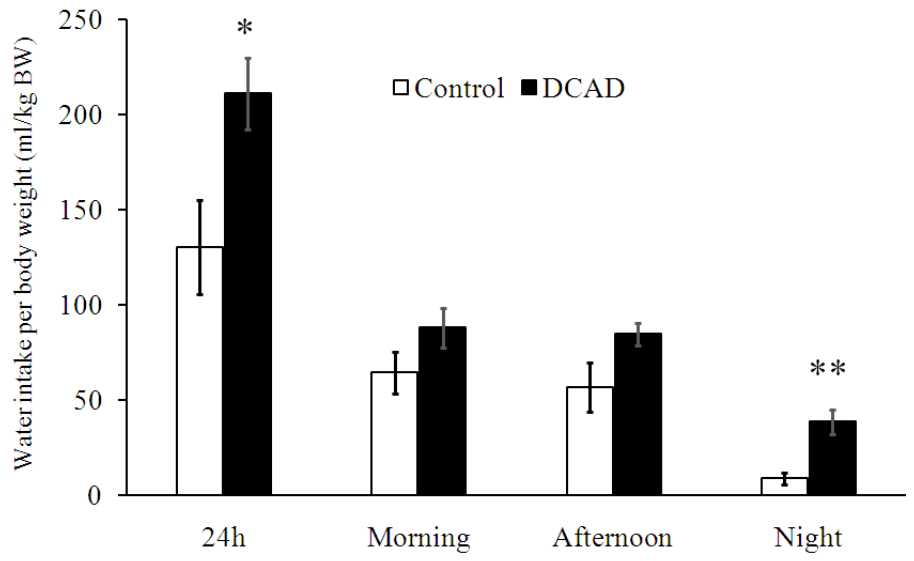
Figure 2. Effects of dietary cation and anion difference (DCAD) on the average 24 h water intake (WI), morning WI from 0700 to 1300 h, afternoon WI from 1300 to 1900 h; night-time WI from 1900 to 0700 h. The DCAD levels from DCAD-23 and DCAD-39 groups were 22.8 and 39.1 mEq/100 g DM, respectively. Asterisks indicate significant differences within each period, * p<0.05; ** p<0.01.